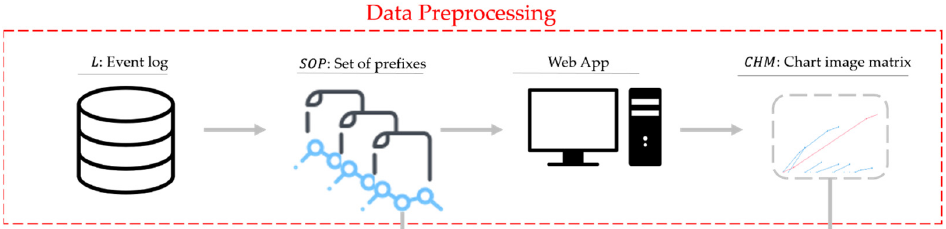
Figure 2. Data preprocessing.